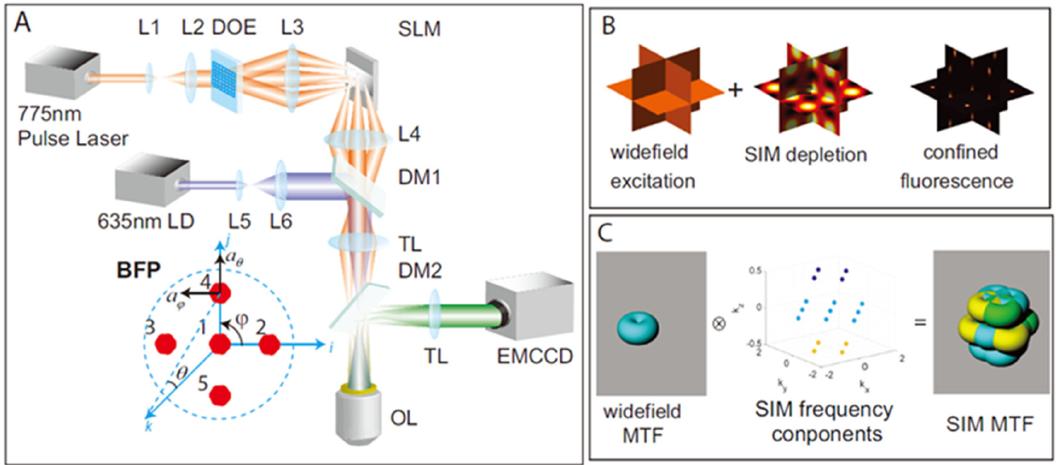
Figure 6. ( A ) Three-dimensional (3D) 5-SIM-STED setup schematic [65]. ( B ) Confined fluorescence signals are generated by 5-SIM-STED. ( C ) 3D 5-SIM-STED solves the problem of the “missing cone” [65]. Copyright 2018 Opt Express.